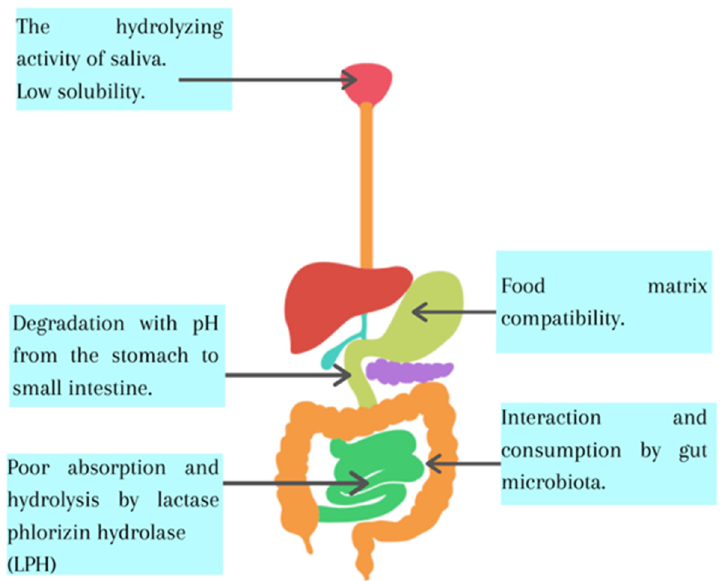
Figure 1. Summary of the factors accounting for the low bioavailability of flavonoids.